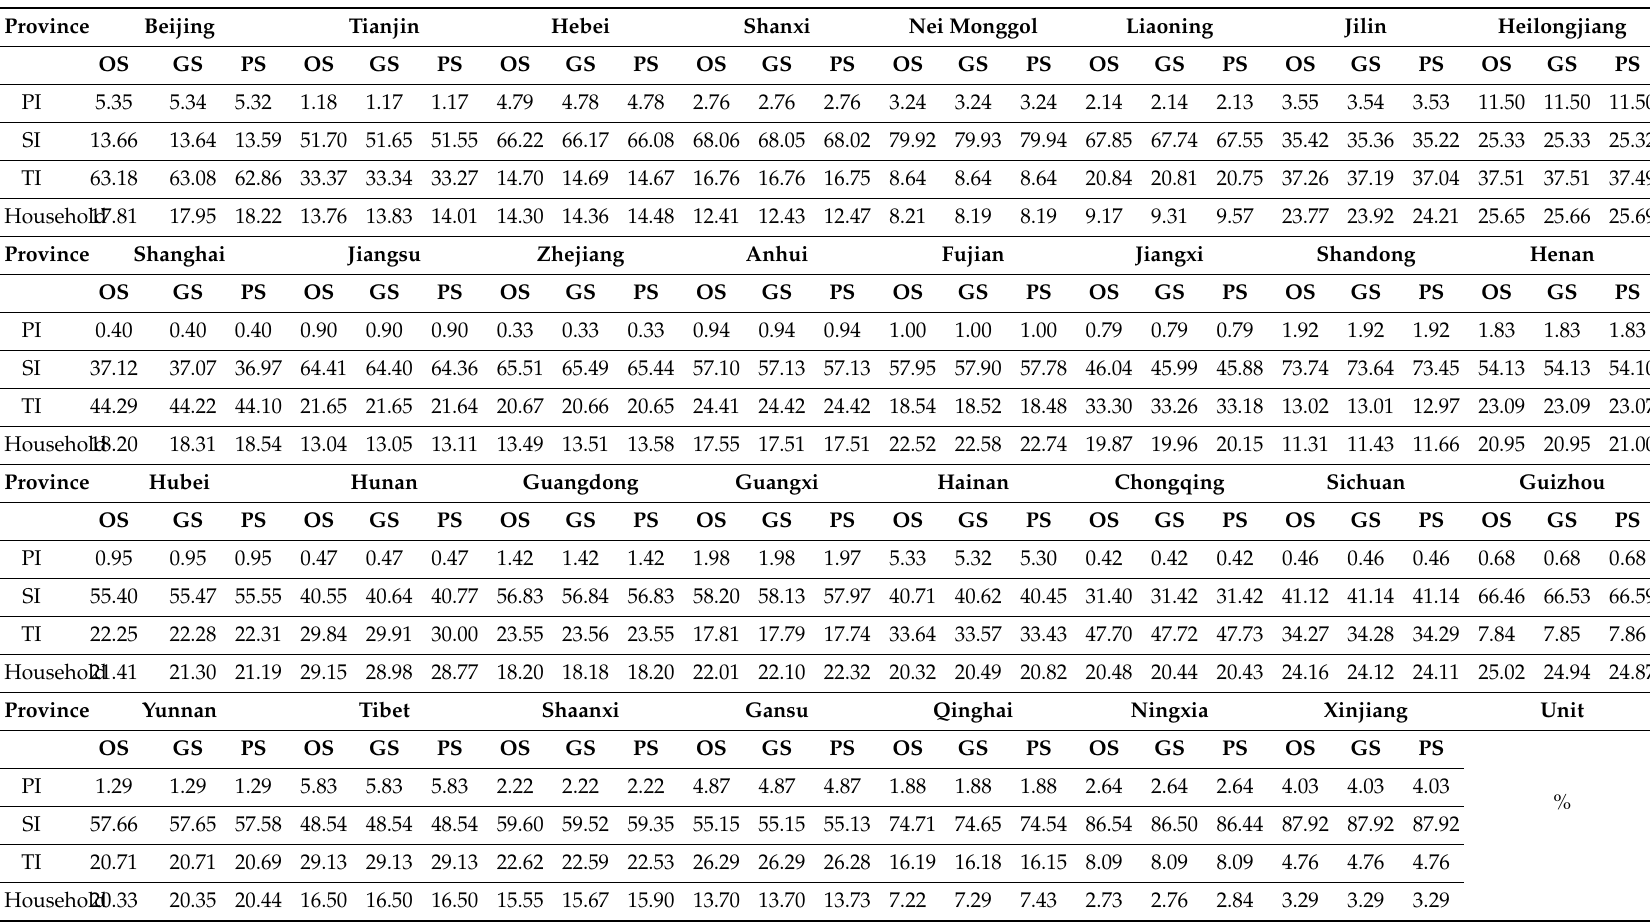
Table A7. Electric consumption structure of each province by scenario in